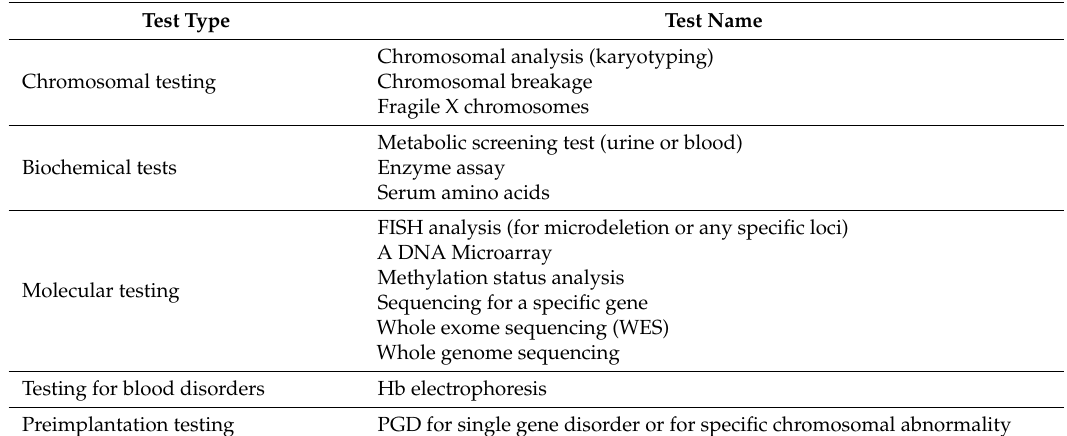
Table 2. List of the types of genetic testing requested in the genetic